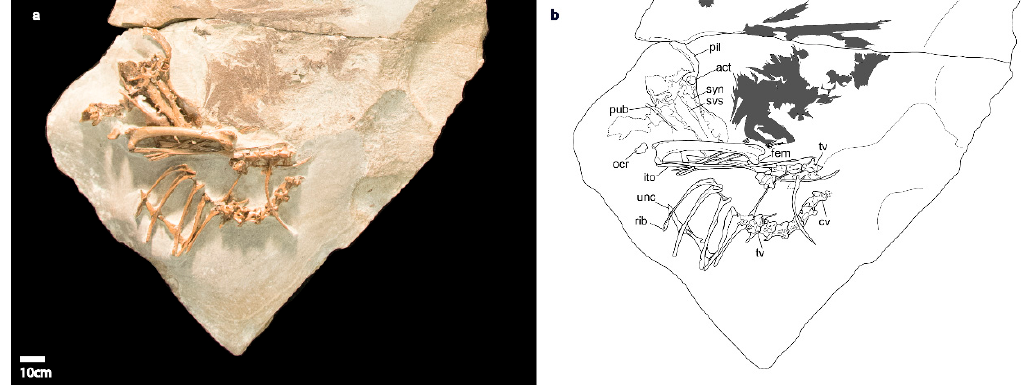
Figure 5. Photograph ( a ) and line drawing ( b ) of referred specimen of Pellornis mikkelseni , FUM 1681a. Soft tissue and plumage is filled in with gray. Dashed borders indicate bone that is extremely broken. Anatomical abbreviations: cv cervical vertebra, tv thoracic vertebra, rib rib, unc unfused uncinate process, syn synsacrum, svs sulcus ventralis synsacrum, ocr os carpi radiale, act acetabulum, pub pubis, pil postacetabular ilium, ito intratendinous ossification, fem femur.